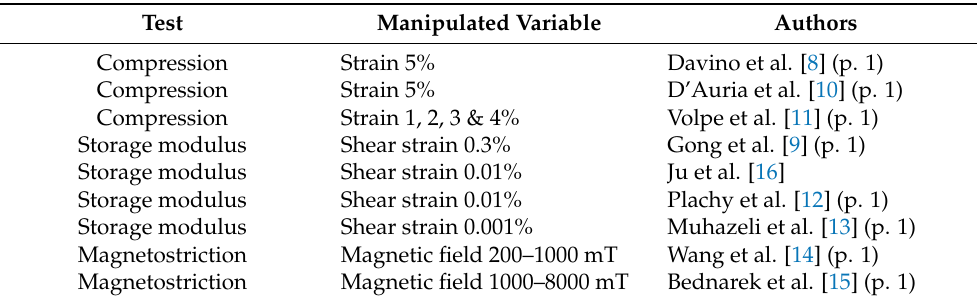
Table 1. Selected studies investigating the different mechanical properties of the magnetoactive (MA) foams under magnetic